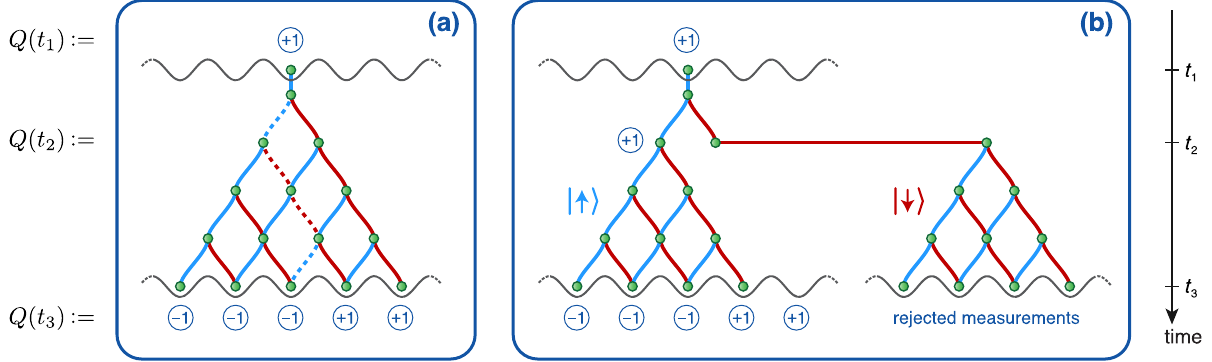
FIG. 2. Ideal negative measurements test the nonclassicality of quantum walks. (a) Schematic representation of a four-step quantum walk containing 16 possible trajectories, which according to quantum mechanics, the Cs atom simultaneously follows. Conversely, upholders of realism believe that in each experiment the atom follows a definite trajectory connecting the initial and final point, e.g., the dashed line shown in the figure. The outcomes (cid:2) 1 of Q ð t i Þ measurements are indicated with circles, where Q ð t 1 Þ is identified with the initial-state preparation, whereas Q ð t 2 Þ and Q ð t 3 Þ are related to position measurements. For instance, measurements at times t 1 and t 3 yield the correlation function h Q ð t 3 Þ Q ð t 1 Þi . (b) To measure the correlation function h Q ð t 3 Þ Q ð t 2 Þi , we use at time t 2 an ideal negative measurement scheme, which ensures the noninvasiveness of Q ð t 2 Þ : On the condition that only atoms in the ↓ state are transported at t 2 far away to the right, atoms in ↑ continue their walk undisturbed. In case Q ð t 2 Þ measurement has not removed the atom, measuring at t 3 the atom ’ s position yields Q ð t 3 Þ conditioned to the state ð ↑ ; x ¼ − 1 Þ at t 2 . Likewise, we obtain Q ð t 3 Þ conditioned to ð ↓ ; x ¼ þ 1 Þ by transporting at t 2 the atom in ↓ far away to the left (not shown in the